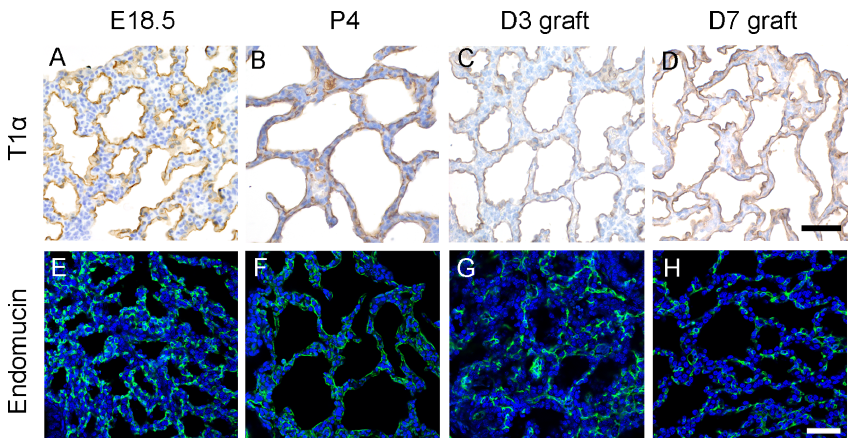
Figure 4. Differentiation of AEC-I cells and blood vessel development in lung allografts. E15.5 WT lungs were diced and implanted underneath the renal capsule. Sections of fetal lung tissues and allografts at indicated time points were immunostained with T1 a or Endomucin antibodies. (A) and (E) E18.5 lung tissues, (B) and (F) P4 lung tissues, (C) and (G) day 3 allografts, (D) and (H) day 7 allografts. T1 a -positive AEC-I cells were found lining the saccular lumen of fetal lung tissues and renal capsule allografts (A–D). Endomucin-positive endothelial cells were found next to